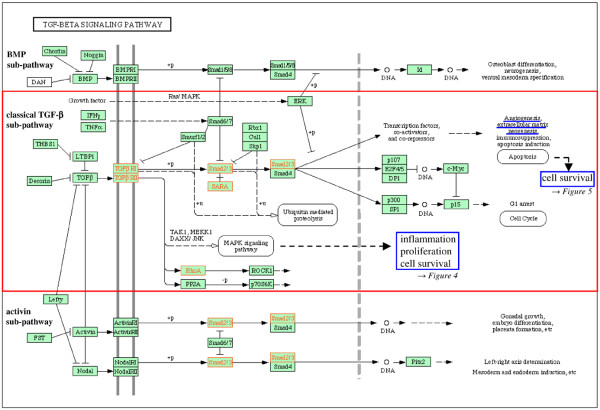
Inter-individual mRNA expression variances in the transforming growth factor-beta (TGF-β) signaling pathway in rheumatoid arthritis (RA) compared with normal control (NC). The graph shows genes affected by significant intra-group inter-individual mRNA expression variances in RA compared with NC (P ≤ 0.05; Bonferroni/Holm corrected Brown-Forsythe version of the Levene test; labeled in red) in the Kyoto Encyclopedia of Genes and Genomes (KEGG) TGF-β signaling pathway. Among the three TGF-β family sub-pathways, the classical TGF-β sub-pathway is significantly affected by gene expression variances (P ≤ 0.15, χ2 test; indicated in red). TGF-β-regulated cellular processes with potential influence on or relevance for RA pathogenesis (for example, angiogenesis and cell survival) are labeled in blue.